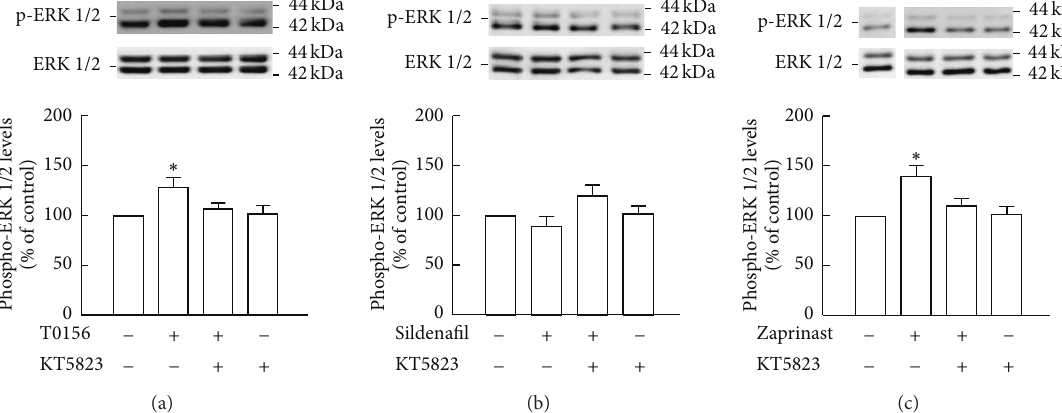
Figure 6: Inhibition of PKG prevented the phosphorylation of ERK1/2 by treatment with T0156 or zaprinast. Levels of phospho-ERK1/2 following treatment with 1 𝜇 M KT5823 and 1 𝜇 M T0156 (a), 1 𝜇 M sildenafil (b), and 10 𝜇 M zaprinast (c) for 2h were assessed by Western blot. Representative images are shown. Data are expressed as means ± SEM of at least 4 independent experiments. One-way ANOVA (Bonferroni’s post-test), ∗ 𝑃 < 0.05 , significantly different from